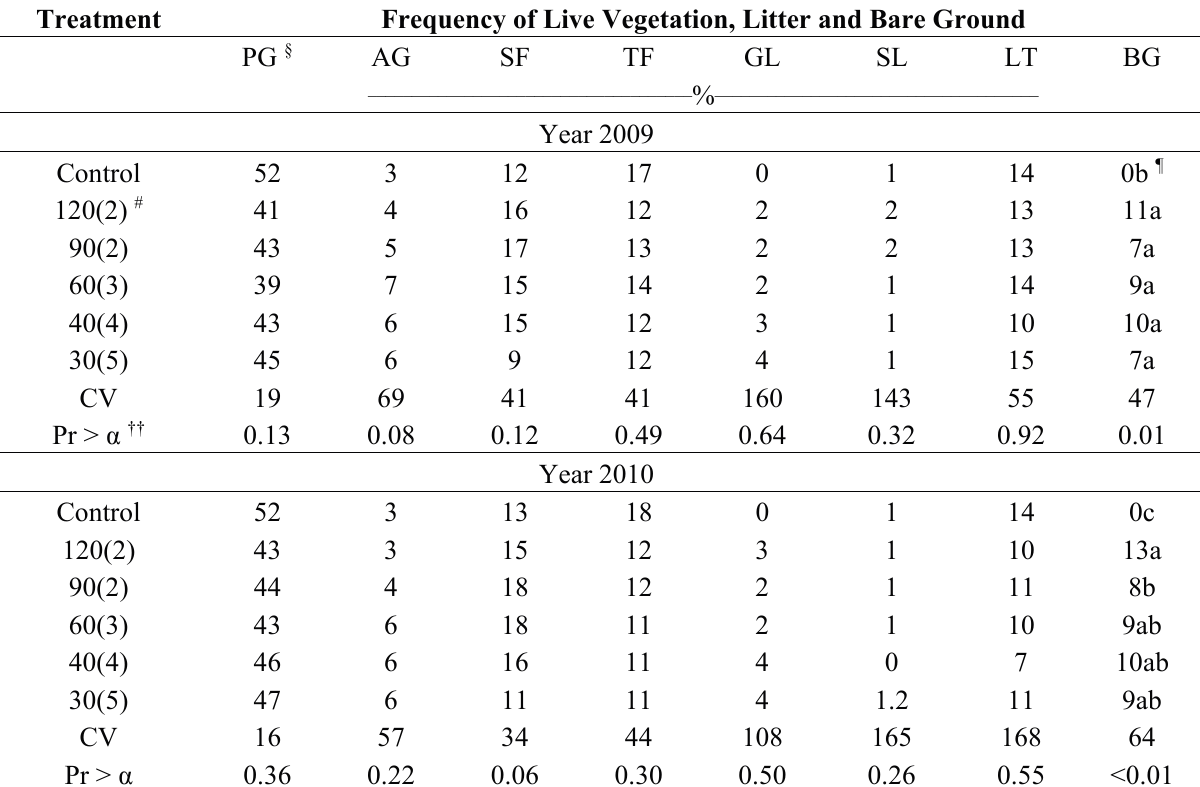
Table 4. Effects of harvest intervals on distribution of major plant types † , litter and bare ground patches in mixed native warm-season grass stands ‡ , previously harvested for one or two years (pooled means), recorded two weeks after mid-May harvest in 2009 and 2010. Treatment Frequency of Live Vegetation, Litter and Bare